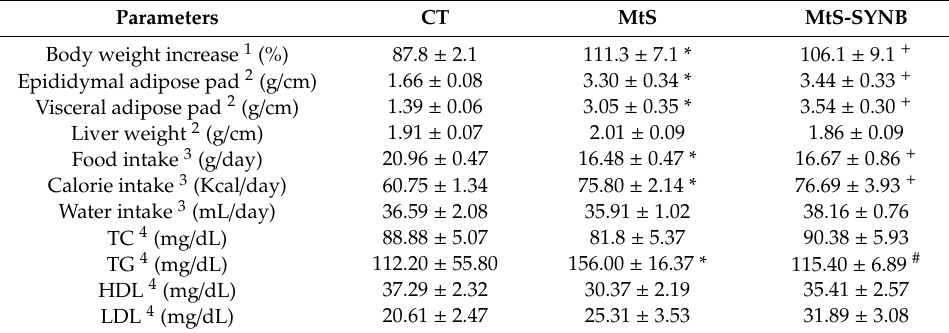
Table 1. Body weight gain, food and water intake and lipid profile.